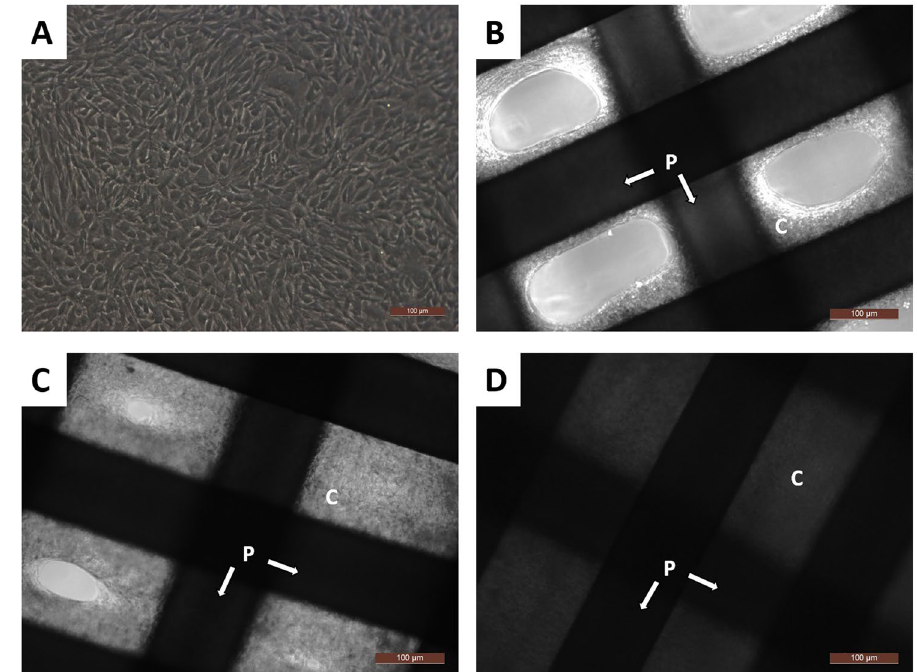
Figure 2. Observation of cell-adhesion to the PCL scaffold with light microscopy. ( A ) Morphology of chondrocytes on second passage using a light microscope. ( B ) 3 Days, ( C ) 7 Days, (D) 14 Days post incubation. Note the decrease of light penetrance on the PCL bars (P) in Fig. 2C and D compared to Fig. 2B due to scaffold incubation with chondrocytes for 1 and 2 weeks, respectively. Scale bar: 100 μ m. (P: PCL bars. C: chondrocytes and extracellular matrix).